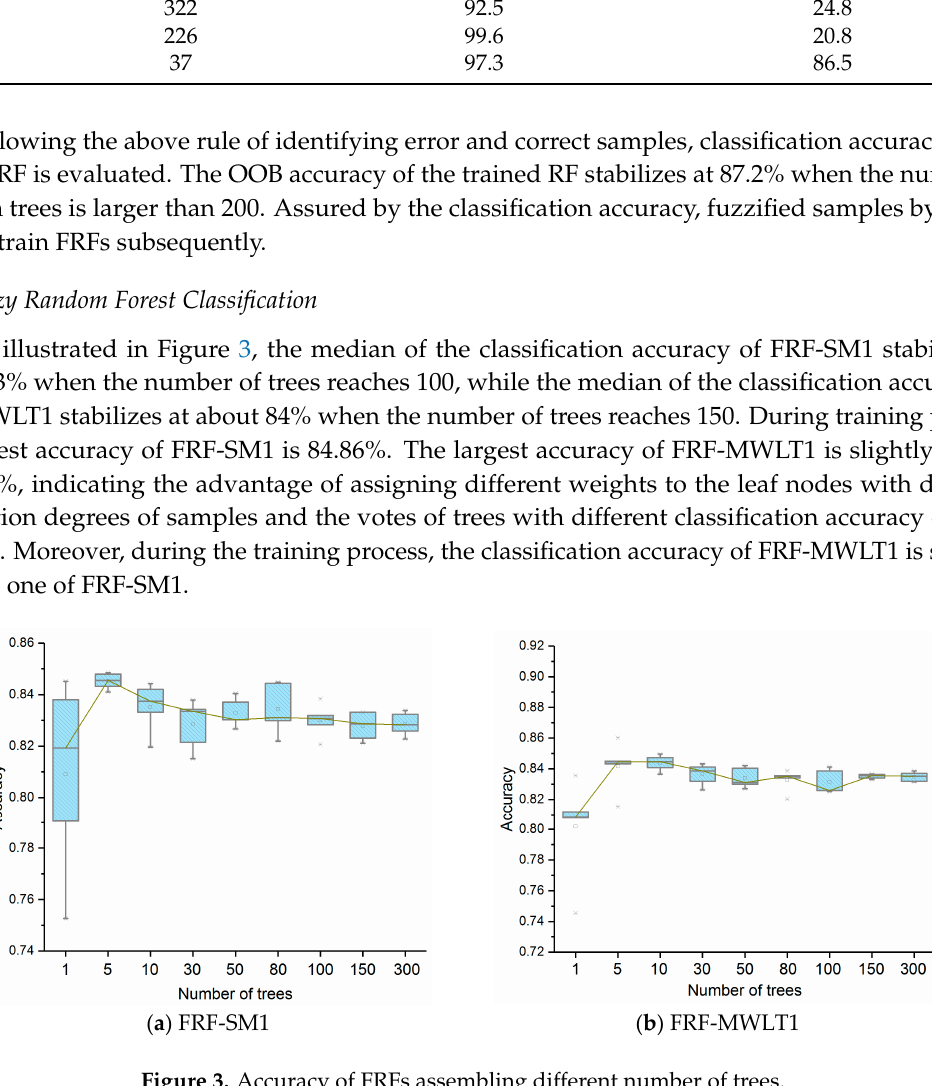
Figure 3. Accuracy of FRFs assembling different number of trees.